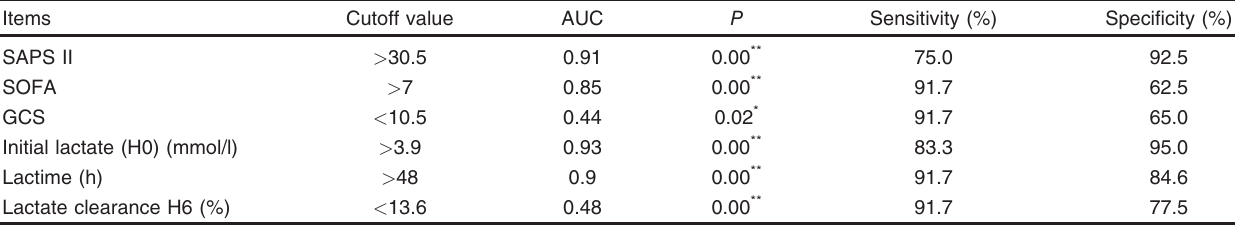
Table 5 Validity of cutoff values of Simplified Acute Physiology Score II, Sequential Organ Failure Assessment, Glasgow Coma Scale, initial blood lactate level (H0), lactime, and clearance as predictors for mortality